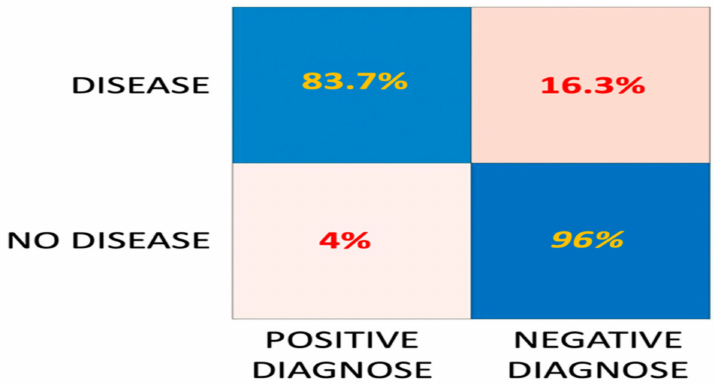
Figure 5. Detailed classification metrics of the ensemble